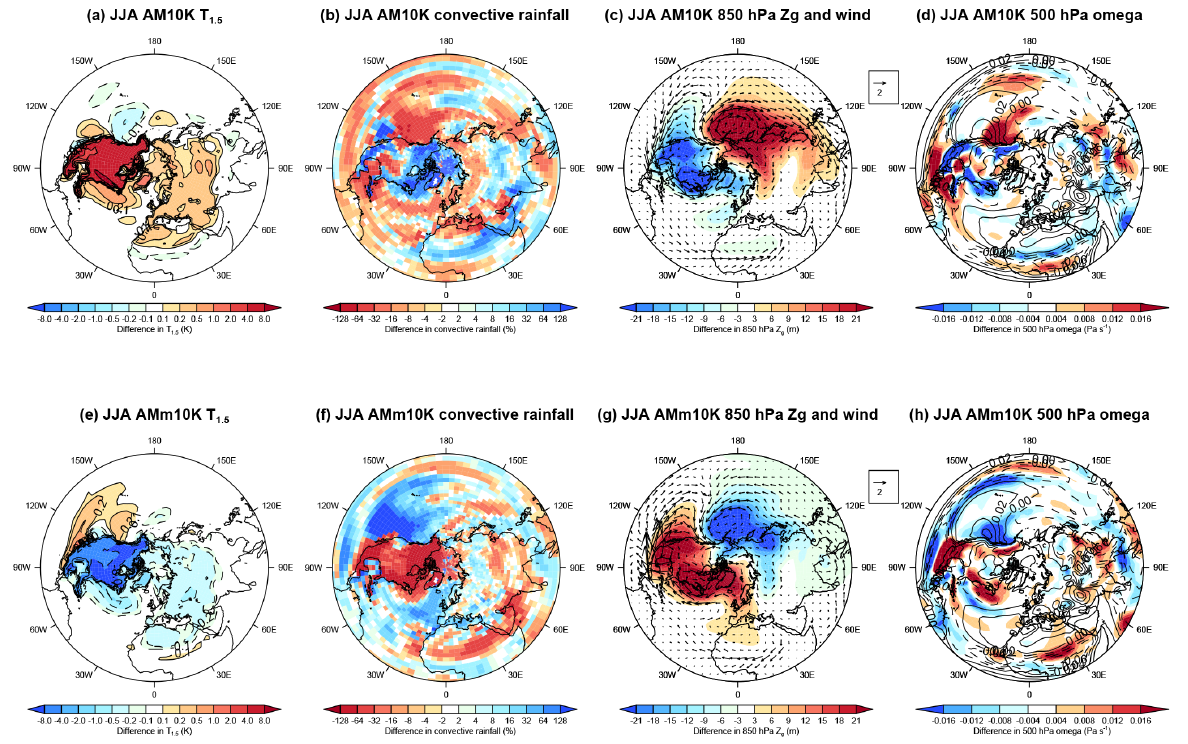
Figure 11. The JJA-mean differences between AM10K and CON1 simulations for (a) T 1 . 5 (K), (b) convective precipitation (%), (c) 850hPa geopotential height (m) and wind field (ms − 1 ), and (d) the 500hPa pressure vertical velocity ( ω 500 , Pas − 1 , shaded) with the JJA-mean ω 500 from CON1 overlaid (solid/dashed lines for positive/negative ω 500 ). The JJA-mean differences between AMm10K and CON1 simulations for (e) T 1 . 5 (K), (f) convective precipitation (%), (g) 850hPa geopotential height (m) and wind field (ms − 1 ), and (h) ω 500 (Pas − 1 , shaded) with the JJA-mean ω 500 from CON1 overlaid (solid/dashed lines for positive/negative ω 500 ).